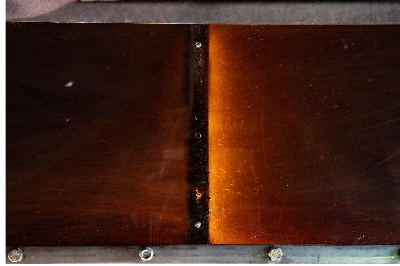
Figure 15. The approaching side ( right ) is brighter than exit side ( left ). (Stainless Steel Wire and Mesh Pty Ltd. [17]).